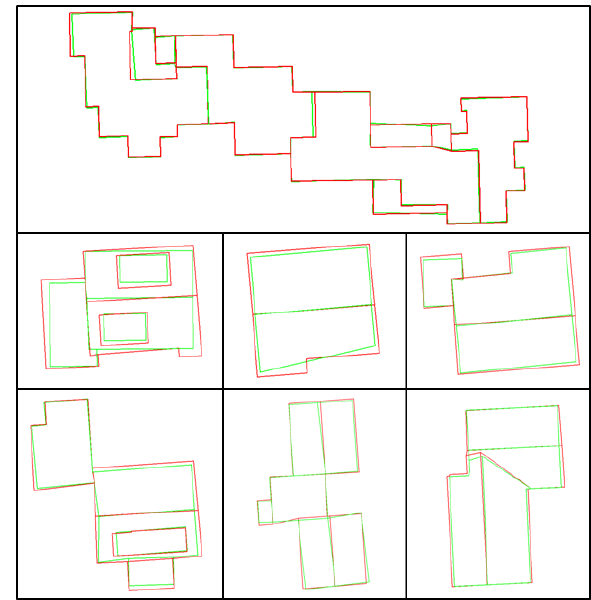
Figure 8. Building models from LiDAR (green) and building models refined by image